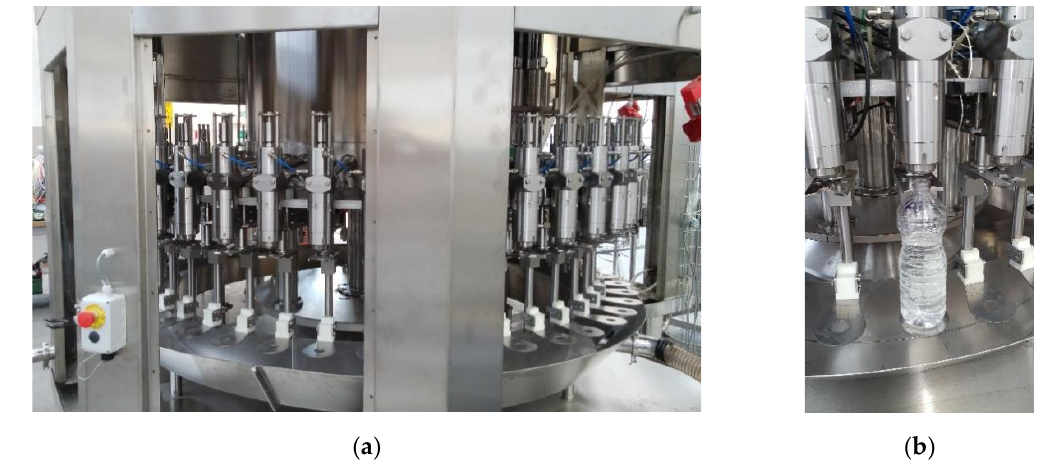
Figure 1. ( a ) Detail of the main carousel of a weight filler. ( b ) Details of a station: fluid dispenser and bottle holder plate.